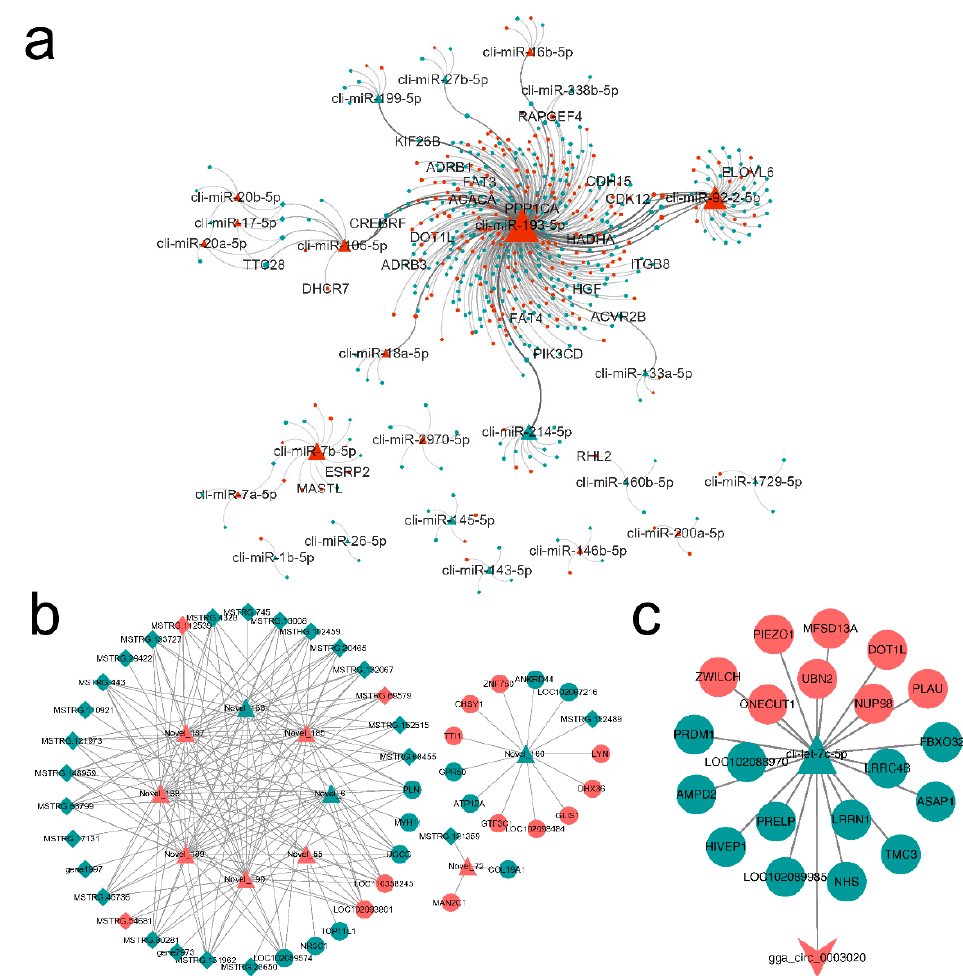
Figure 5. ceRNA network for target RNA molecules of the differentially expressed miRNAs between lactating and non- lactating pigeon crops. Triangular, ellipse, diamond, and V nodes represent miRNA, mRNA, lncRNA and circRNA respectively. Red represents up-regulation and green represents down-regulation. The ceRNAs were connected by edges. ( a ) known miRNA-mRNA-lncRNA network. ( b ) Novel miRNA-mRNA-lncRNA network. ( c ) miRNA-mRNA-circRNA network.